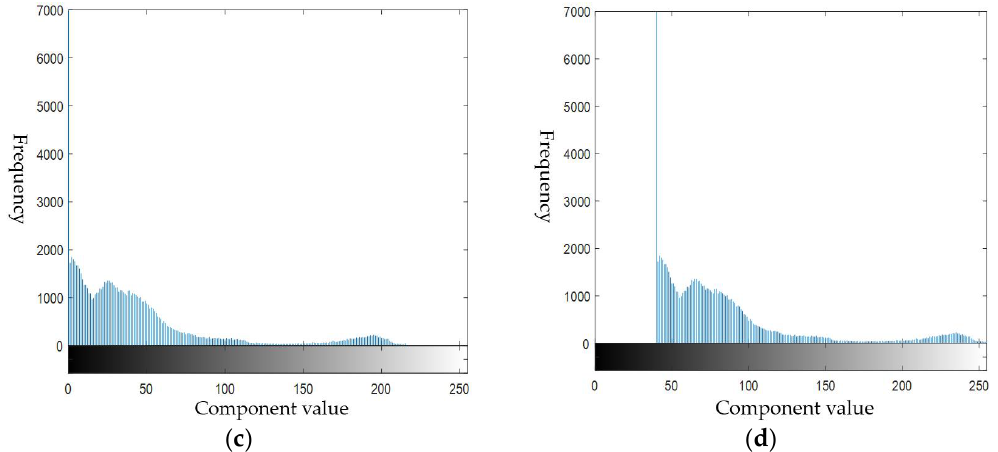
Figure 5. Comparison of R component before and after rotation. ( a ) The original R component image; ( b ) the R component image after rotation; ( c ) the original R component histogram; ( d ) the R component histogram after rotation.